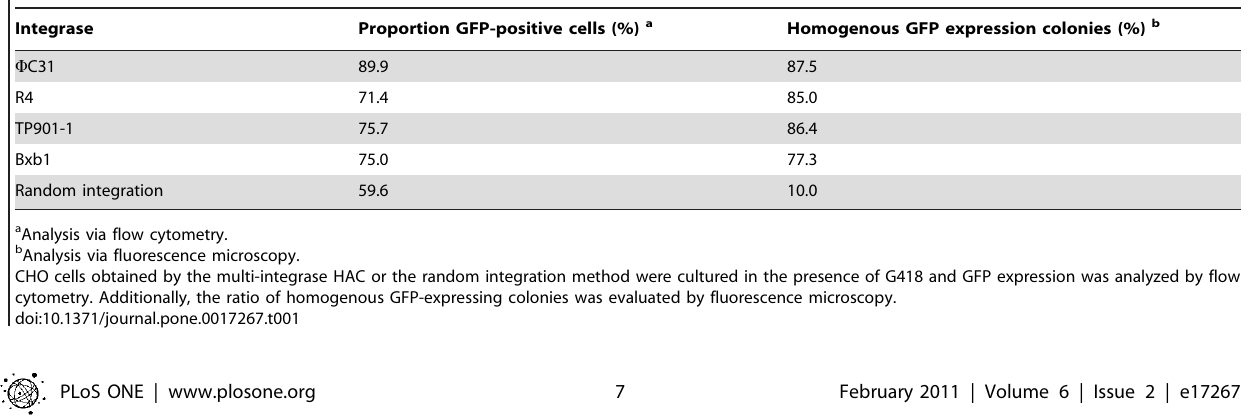
Figure 3. Comparison of the efficiency in generating transgenic cells. (A) Schematic diagram of the insertion of the plasmid containing the CMV promoter and the EGFP gene in the multi-integrase HAC vector or host chromosome. Under both conditions, cells were incubated with the reagent/DNA mixture for 24 h and selected with G418 until drug-resistant cell pools were obtained. (B) Flow cytometry analysis of the fluorescent profile of transfected CHO cells on day 12 following selection by G418 after transfection. The bars indicate the GFP-expressing cell population. (C) Expression of the inserted EGFP gene was tracked in cells by fluorescence microscopy. Typical images (bright field, upper panels; fluorescence, lower panels) of cells obtained by the multi-integrase HAC vector with integrases and random integration are shown. Scale bar, 100 m